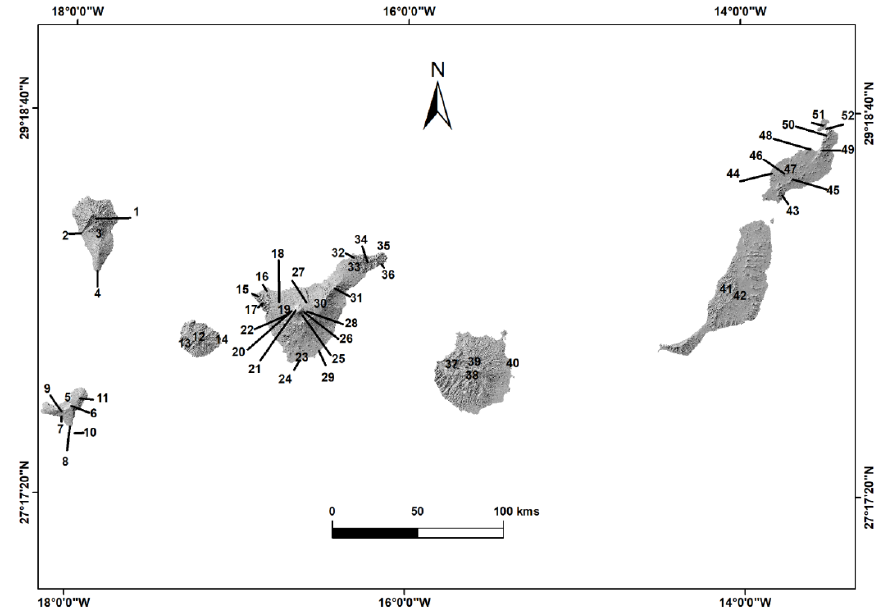
Figure 4 . Overview map of the Canary Islands and zones mentioned in the text. 1-Taburiente. 2-Barranco de las Angustias. 3-Cumbre Nueva. 4-Tenegu í a. 5-El Golfo. 6-Malpaso. 7-Los Lajiales. 8-Las Calmas. 9-Tanganasoga. 10-La Restinga. 11-Tiñor. 12-Garajonay. 13-Valle Gran Rey. 14-Punta Llana. 15-Teno. 16-M. Taco. 17-Masca. 18-V. Garachico 19-Chinyero. 20-Pico Viejo. 21-El Teide. 22-Reventada. 23-Erales. 24-Amarilla. 25-Maj ú a. 26-Blanca. 27-La Fortaleza. 28-Rajada. 29-Pelada. 30-V. Fasnia. 31-Pedro Gil. 32-Las Rosas. 33-SC-La Laguna. 34-Anaga. 35-Benijos. 36-Igueste San Andr é s. 37-Caldera Tejeda. 38-Roque Nublo. 39-Risco Ca í do. 40-Tufia. 41-Betancuria. 42-Caldera de Gair í a. 43-Ajaches. 44-El Moj ó n. 45-Los Volcanes. 46-Timanfaya. 47-Tinguat ó n. 48-Cavera. 49-Peñas Chache. 50-Famara. 51-La